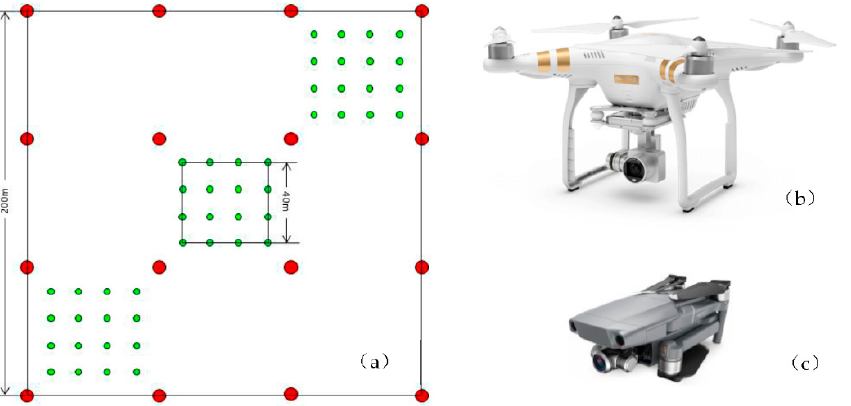
Figure 2. Strategy of field observation and data collection: ( a ) strategy of observation site; ( b ) Phantom 3 professional and ( c ) Mavic 2 zoom Quad-Rotor intelligent UAVs.